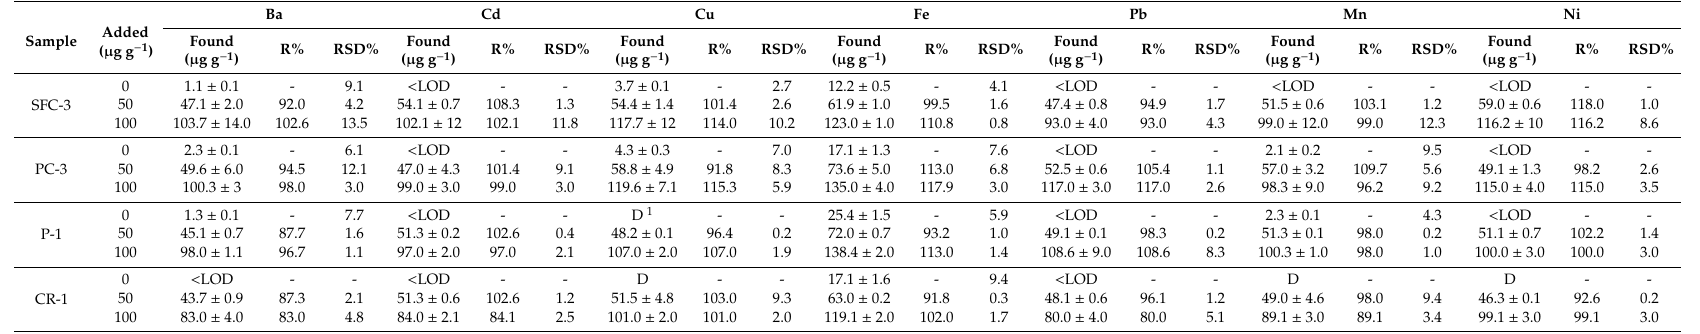
Table 4. Relative recoveries and RSD% values for Ba, Cd, Cu, Fe, Pb, Mn and Ni for the analysis of spiked savory snack samples.